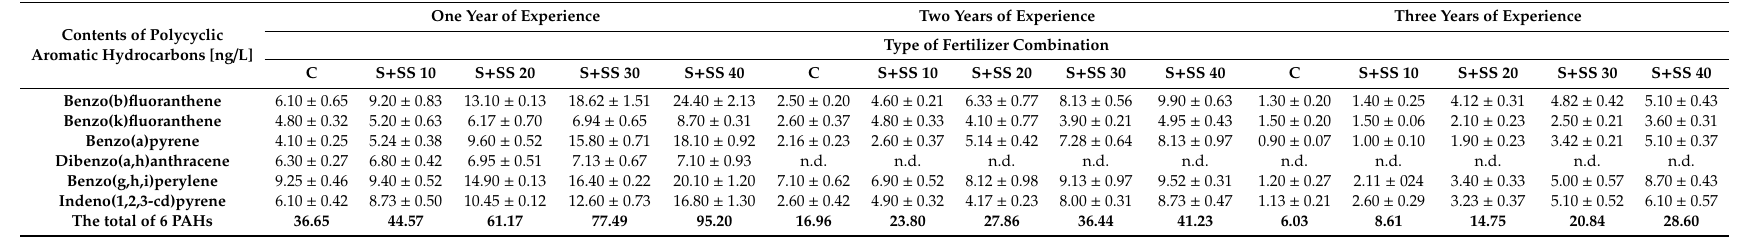
Table 4. Content of PAH in leachate from soil mixtures [ng /